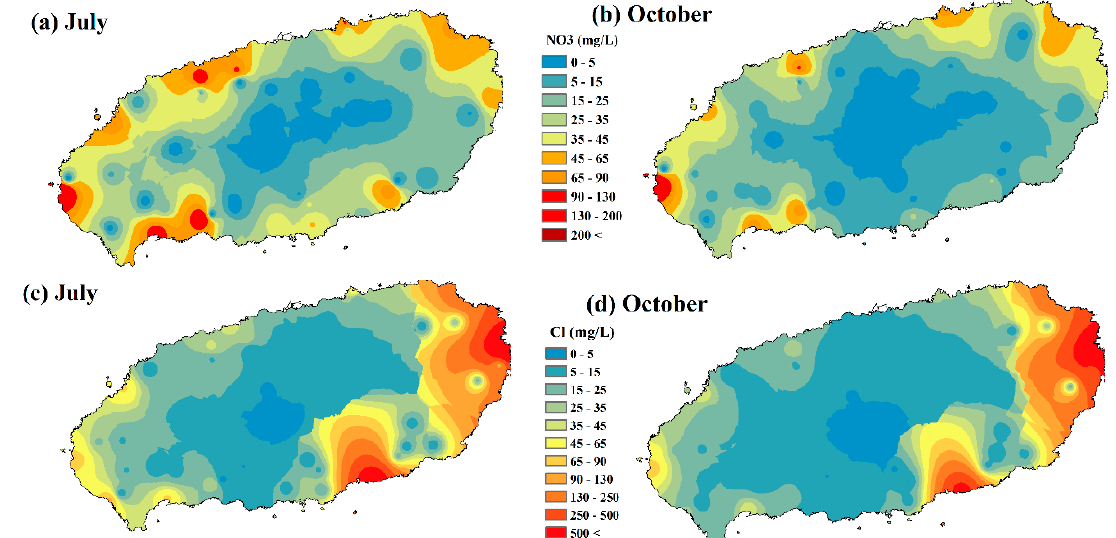
Figure 6. Kriging maps of the NO 3 and Cl contents of groundwater and spring water in Jeju Island. ( a ) and ( b ) represent the kriging maps of NO 3 concentration at July and October, respectively; ( c ) and ( d ) show the kriging maps of Cl concentration at July and October, respectively.